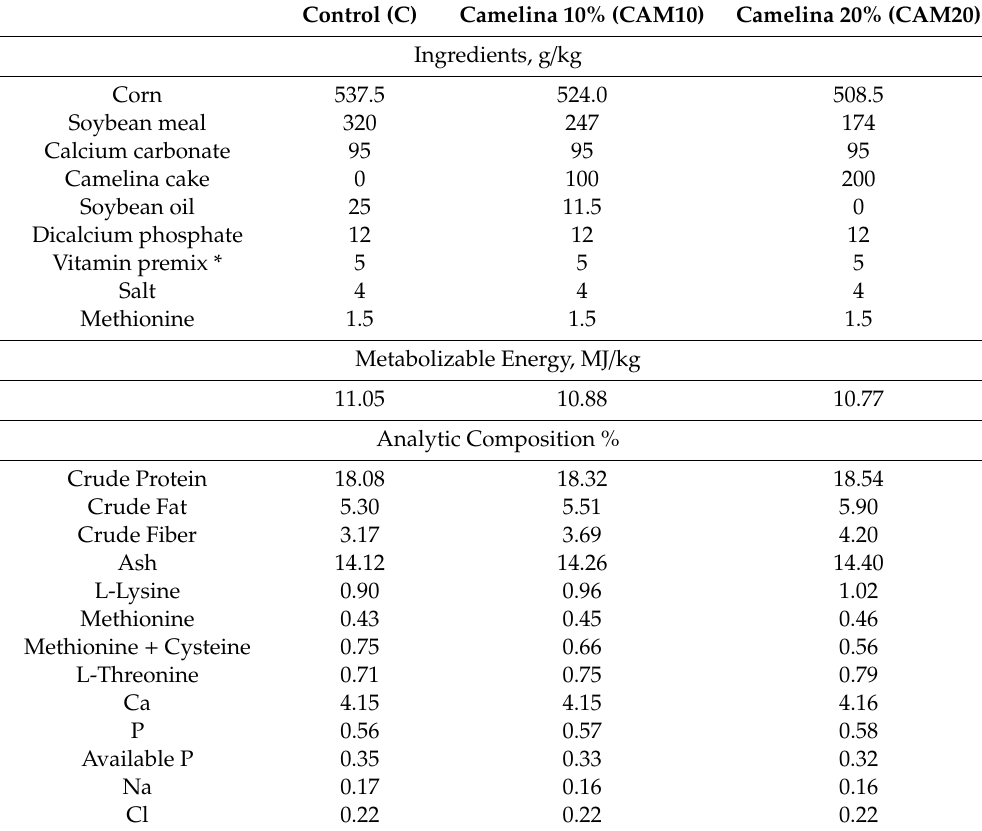
Table 2. Composition of experimental diets and calculated nutrient contents expressed as